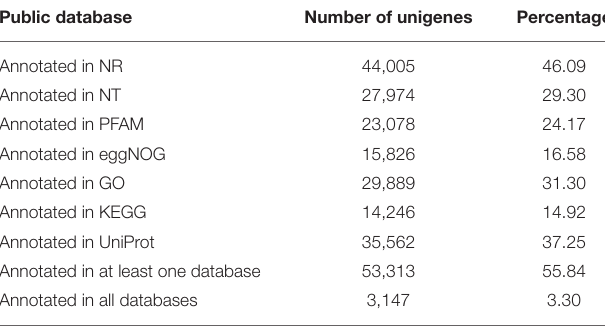
TABLE 3 | Sequence annotation of the Alopecurus aequalis